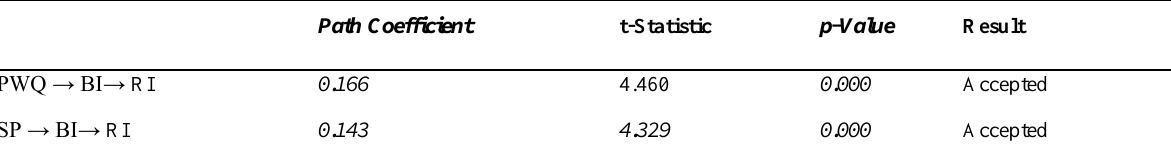
Table 5: Indirect Hypothesis